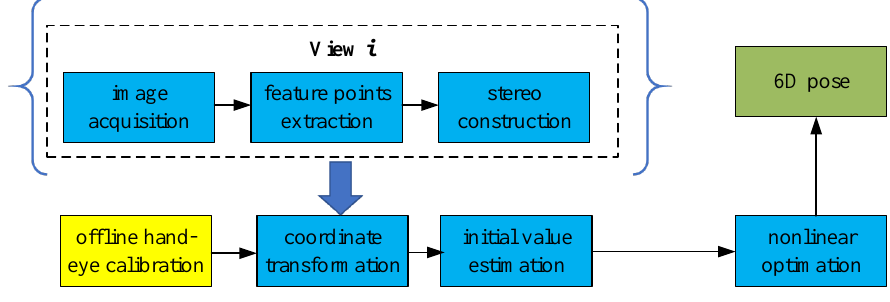
Figure 3. The framework of the multi-view-based 6D pose estimation